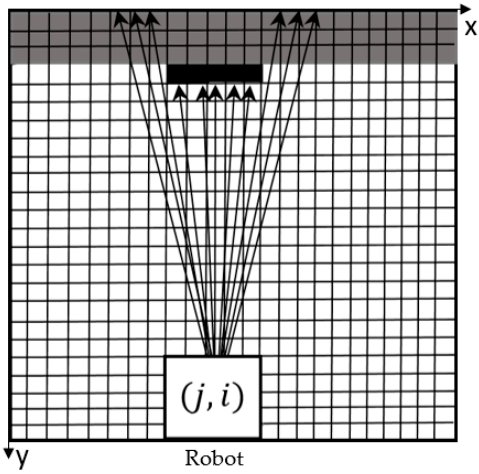
Figure 6. Schematic diagram of obstacles that may be encountered. Table 1. Weights assignment of 11 rays.